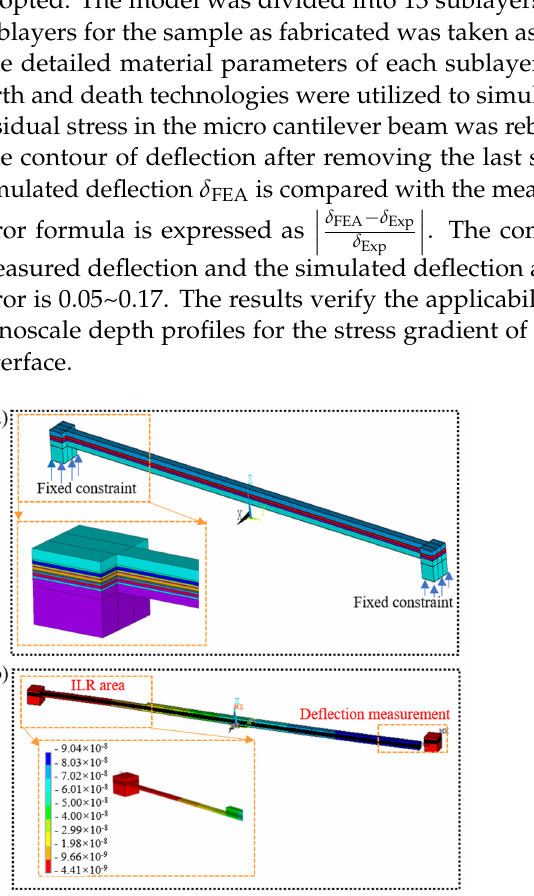
Figure 11. FE model and deflection contour: ( a ) FE model of the micro cantilever beam; ( b ) deflection contour after removing the last sublayer.